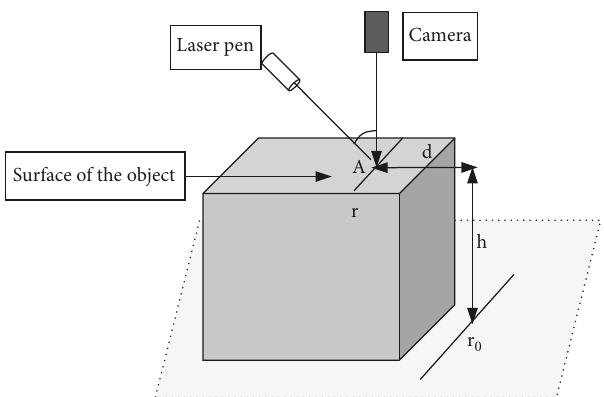
Figure 3: With interference laser mask.